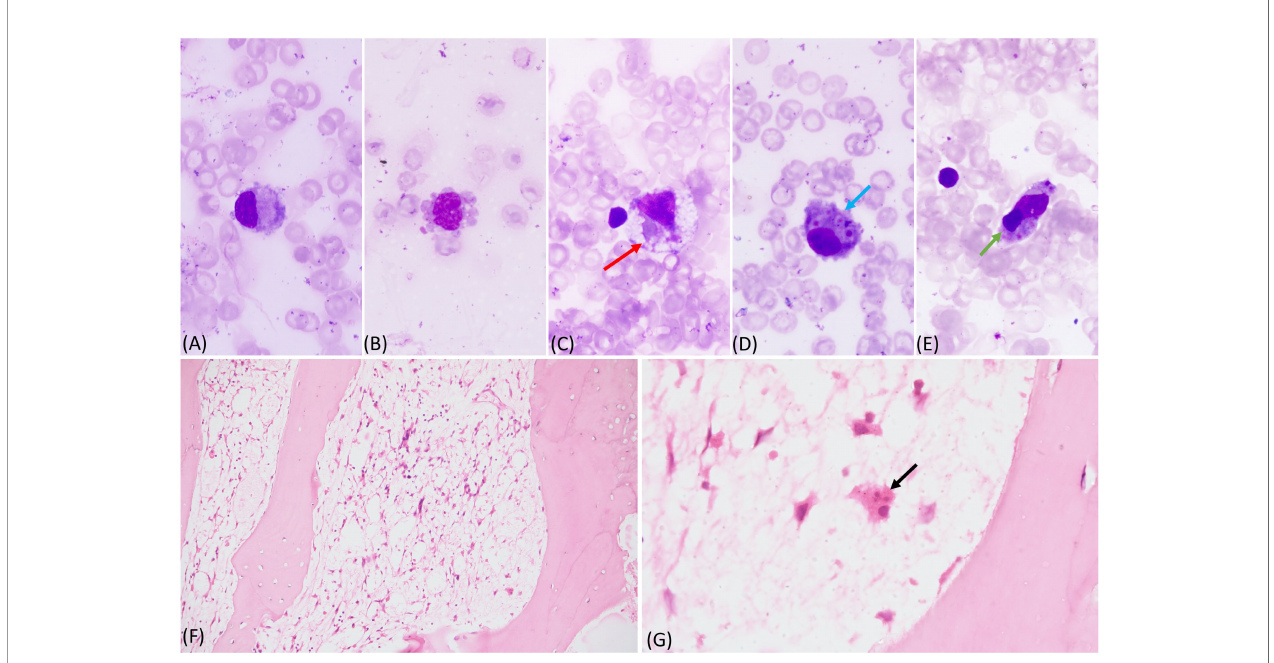
FIGURE 2 | (A-E) Bone marrow aspirate showing histiocytes with pseudopods and vacoules, phagocytosed red cells (red arrow), platelets (blue arrow), and lymphocyte (green arrow) (May Grunwald Giemsa stain 100x); (F, G) markedly hypocellular bone marrow biopsy with marked reduction of all normal hematopoietic cells. A histocyte is visible with phagocytosed neutrophil (black arrow) (Hematoxylin and Eosin, F - 20x and G -